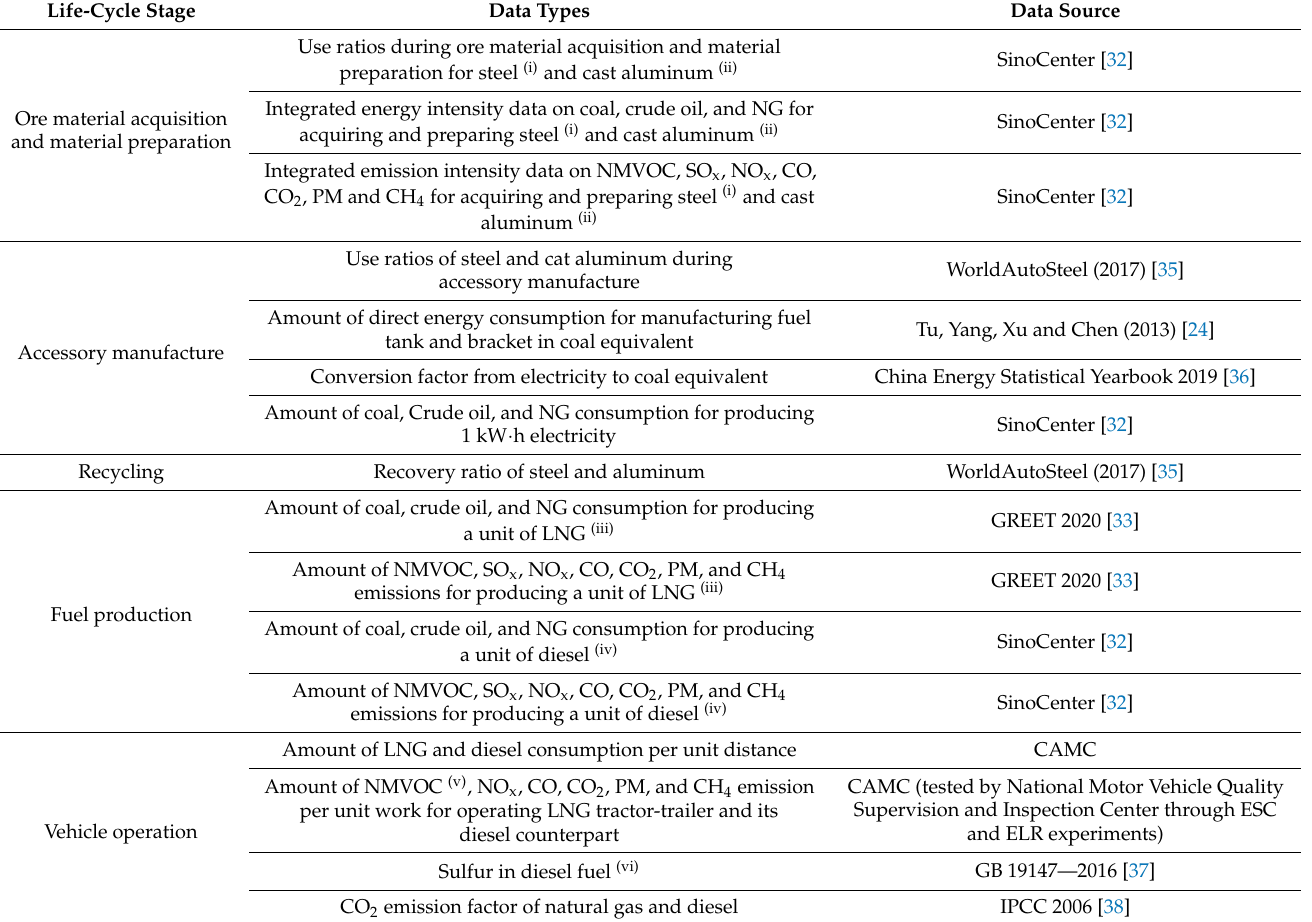
Table 3. Data sources of inventory data for different life-cycle